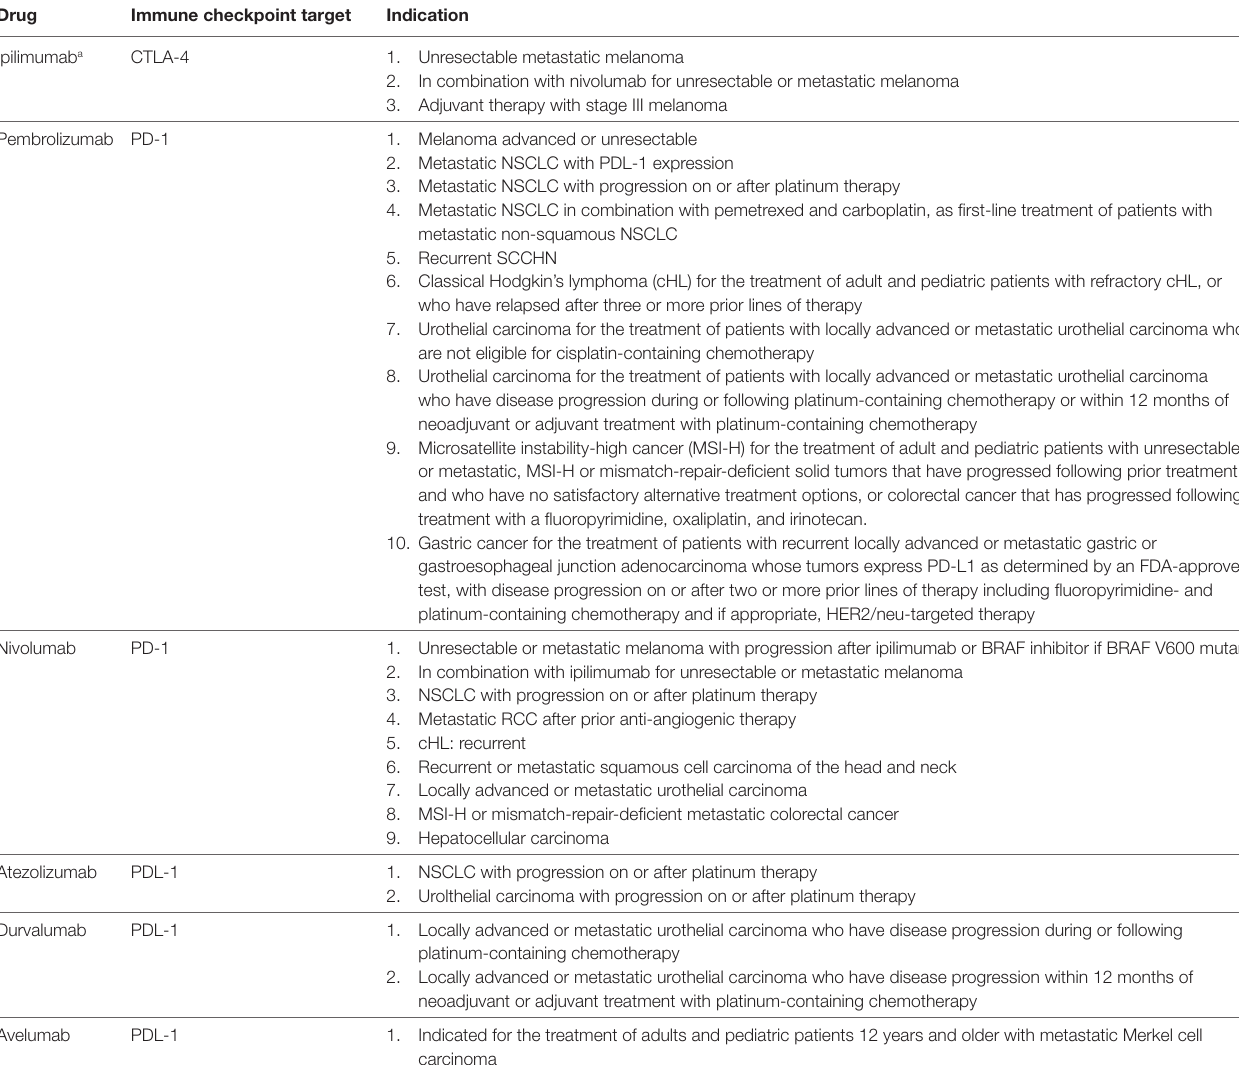
TABLe 1 | Currently approved immune checkpoint inhibitory monoclonal antibodies and their clinical applications in onco-immunotherapy.